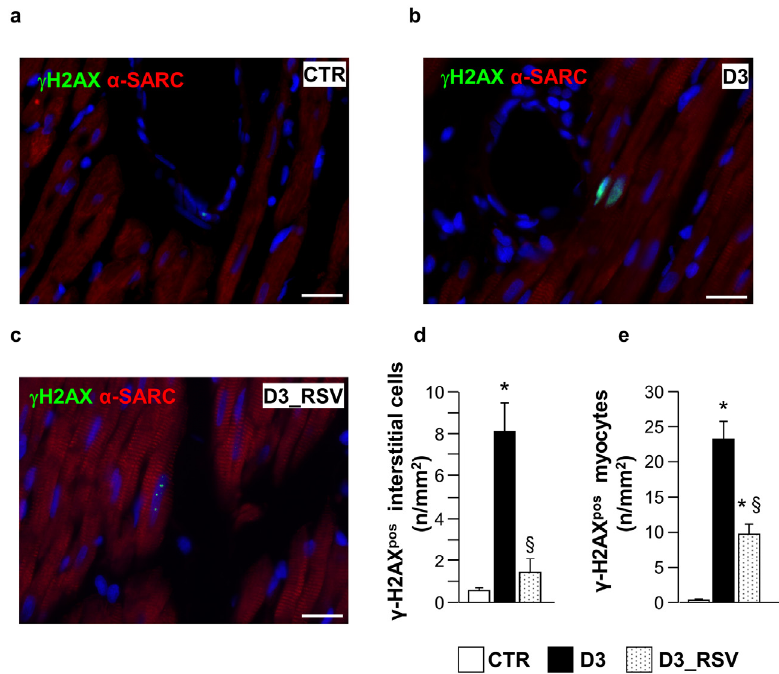
Figure 6. RSV treatment reduced diabetes-induced DNA damage. Panels a–c: detection of DNA double strand breaks in sections of the LV myocardium from control ( a ), untreated ( b ) and RSV-treated ( c ) diabetic rats, by immunofluorescence. Nuclear labeling by antibodies against gamma-Histone2 AX (green, γ H2AX) is documented in cardiomyocytes recognized by the red fluorescence of α -sarcomeric actin (red). Two cardiomyocytes show diffuse nuclear fluorescence in the D3 heart while dot-like signals are present in a cardiomyocyte from RSV-treated myocardium. Blue fluorescence corresponds to DAPI staining of nuclei. Scale bars: 20 µ m; In ( d – e ), bar graphs illustrating the density of γ H2AX positive interstitial cells ( d ) and cardiomyocytes ( e ), in control (CTR), untreated (D3) and RSV-treated (D3_RSV) diabetic myocardium. Data are reported as mean ± SEM * p < 0.05 vs. CTR; § p < 0.05 significant differences between D3 and D3_RSV (one-way ANOVA, Games-Howell post-hoc test).